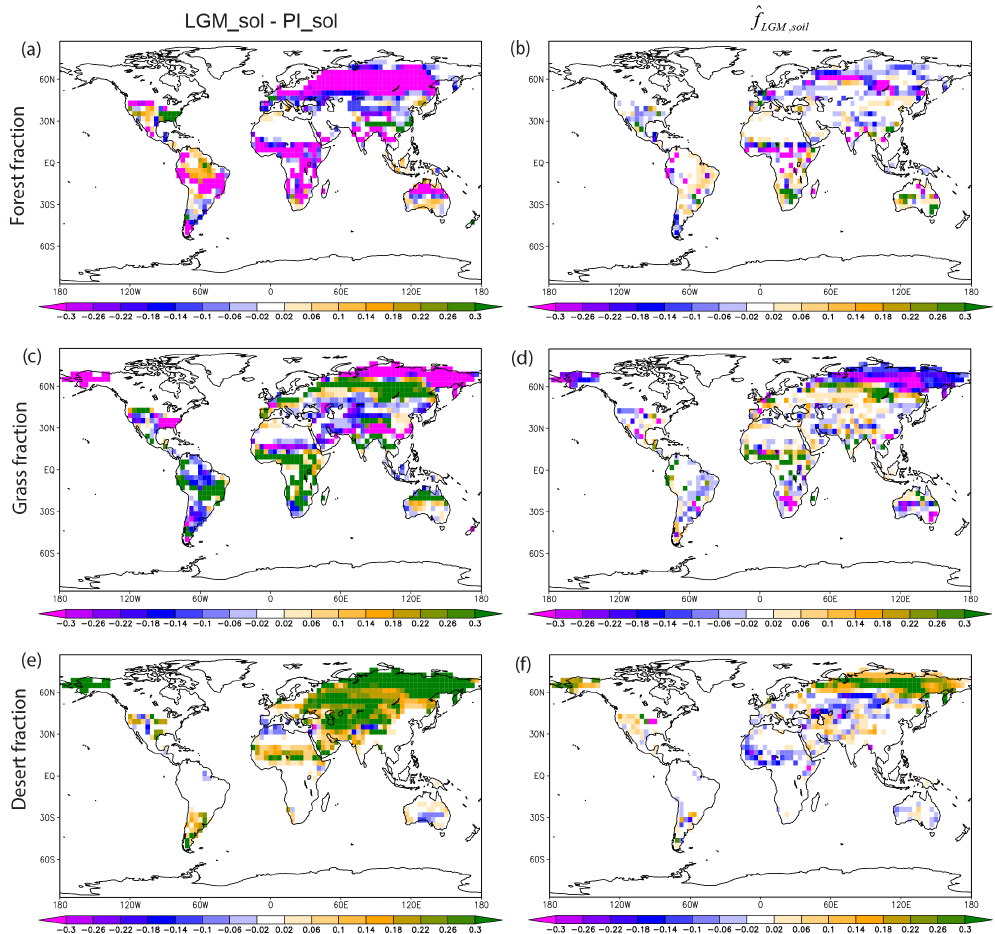
Figure 11. As Fig. 7 but for the Last Glacial